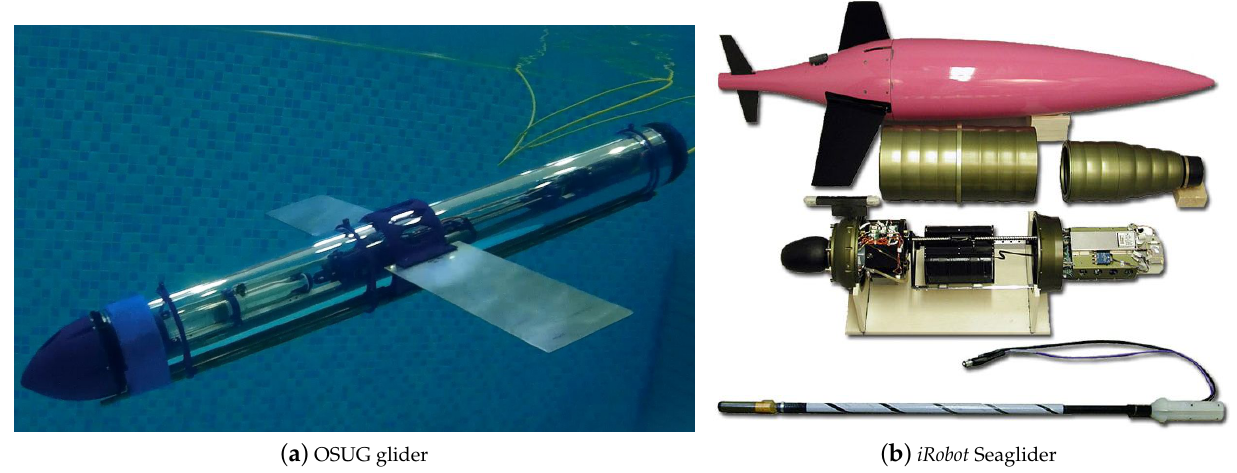
Figure 5. Examples of underwater gliders